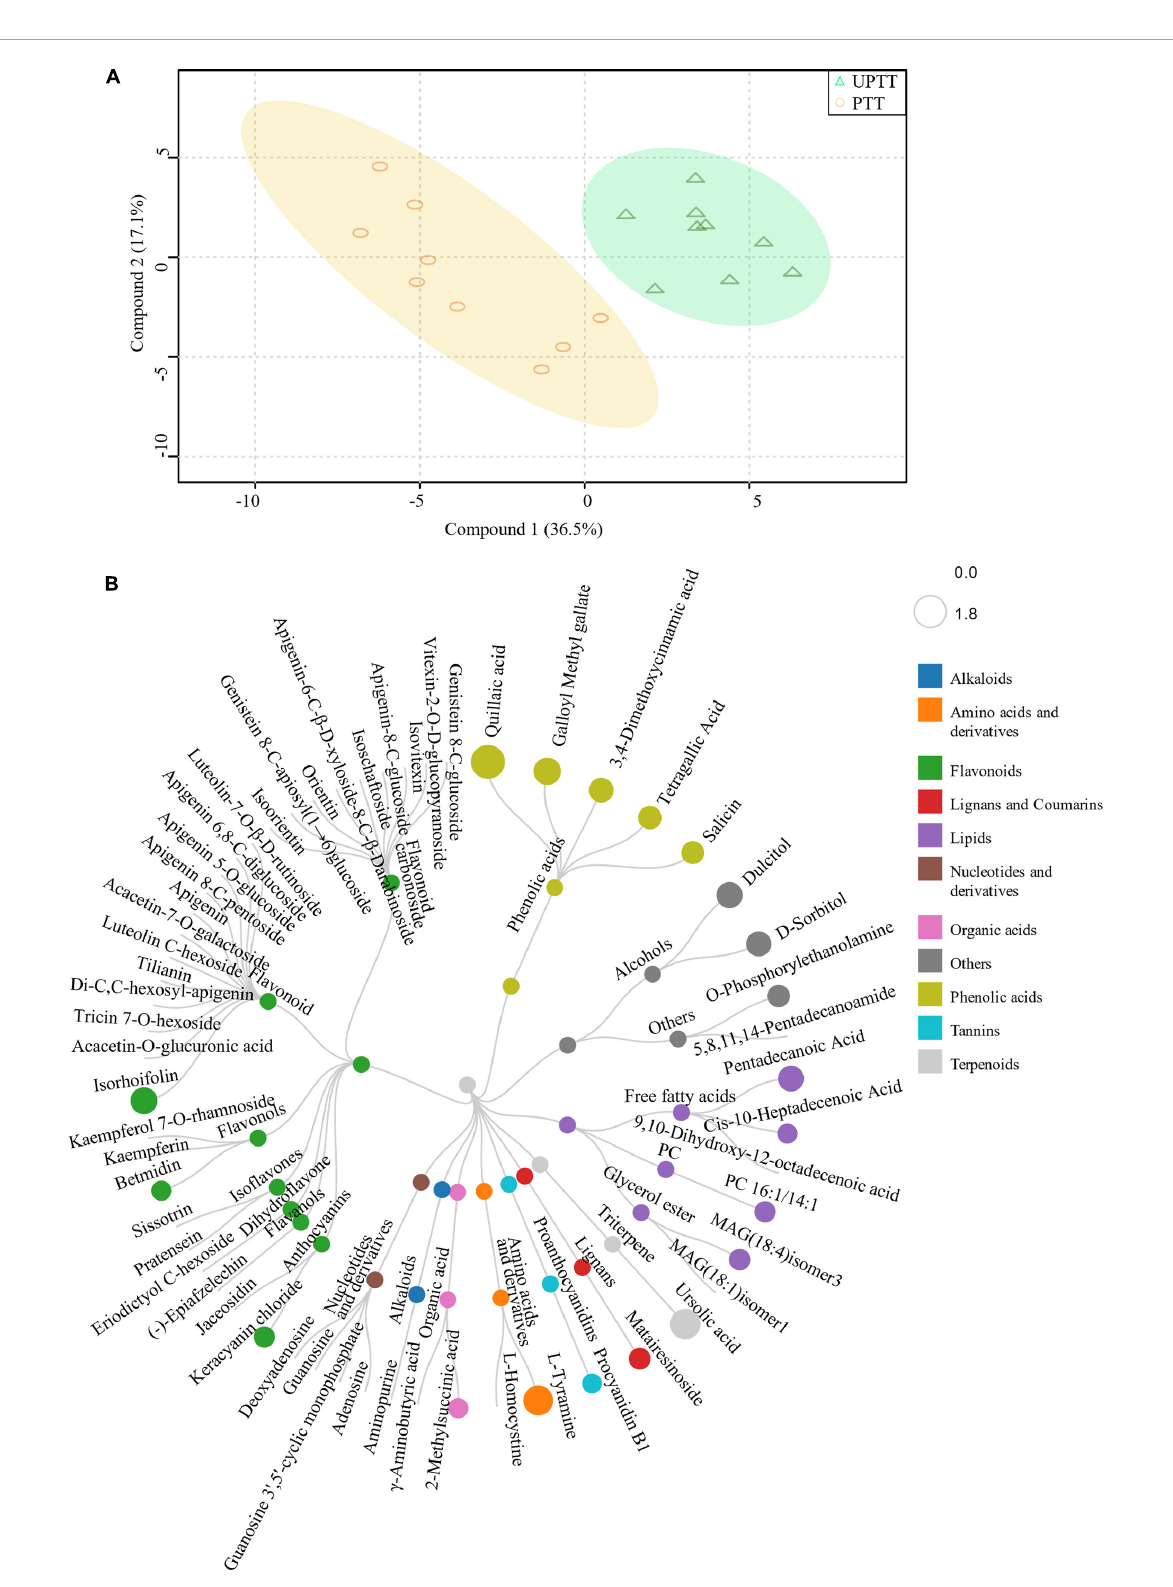
FIGURE6 The OPLS-DA analysis of peak areas of identified metabolites (A) and differentially changed metabolites (B) .